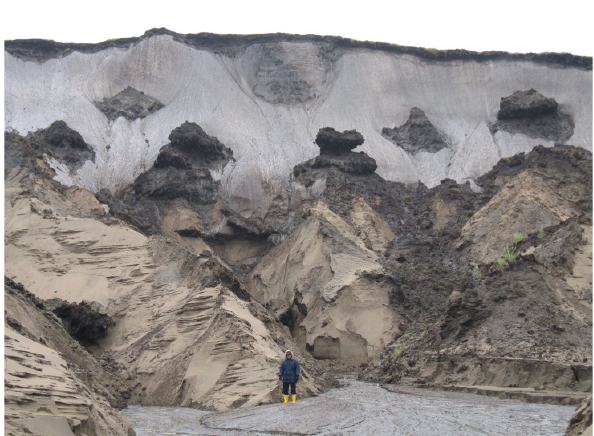
Fig. 2. Typical stratigraphical composition of the study area with lower fluvial sand unit, upper Ice Complex unit, and Holocene cover. Ice wedges in the Ice Complex appear in light grey colors. Person for scale (Photo by M. Ulrich, 26 August 2008).